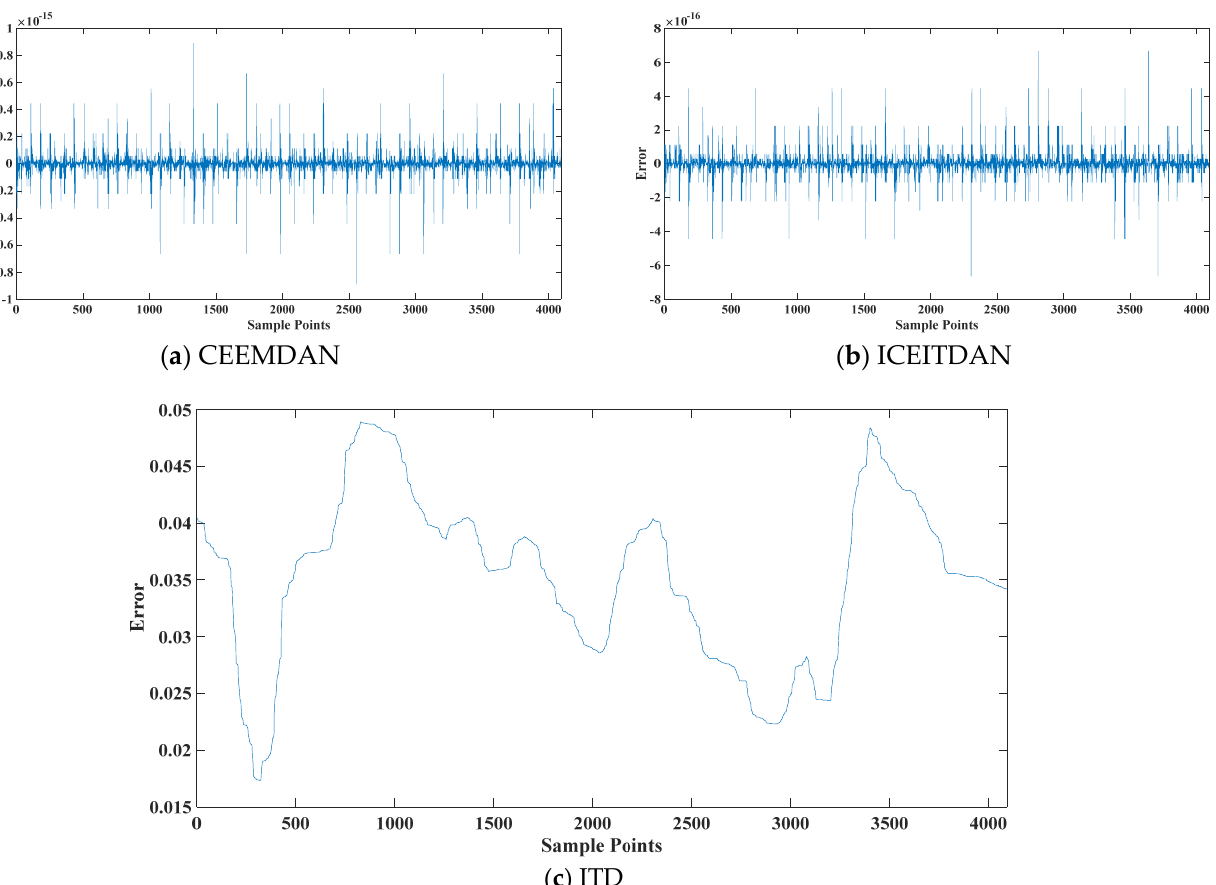
Figure 4. Comparison of the reconstruction errors of three methods: CEEMDAN, ICEITDAN, and ITD. ( a ) CEEMDAN, ( b ) ICEITDAN, and ( c ) ITD.